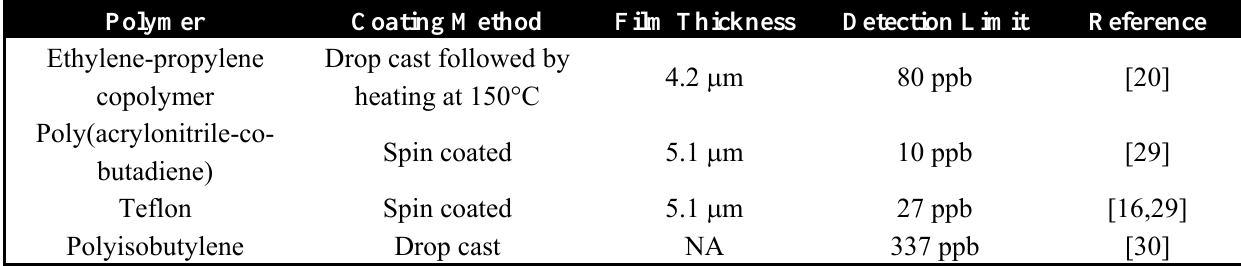
Table 2. The analytical performance of various polymers during ATR-MIR sensing of toluene in